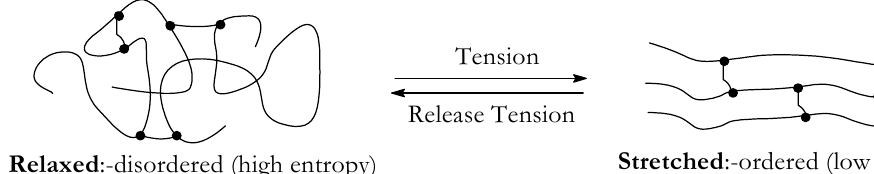
Figure 1. Model of elastomer with a low degree of cross-linking under stress.